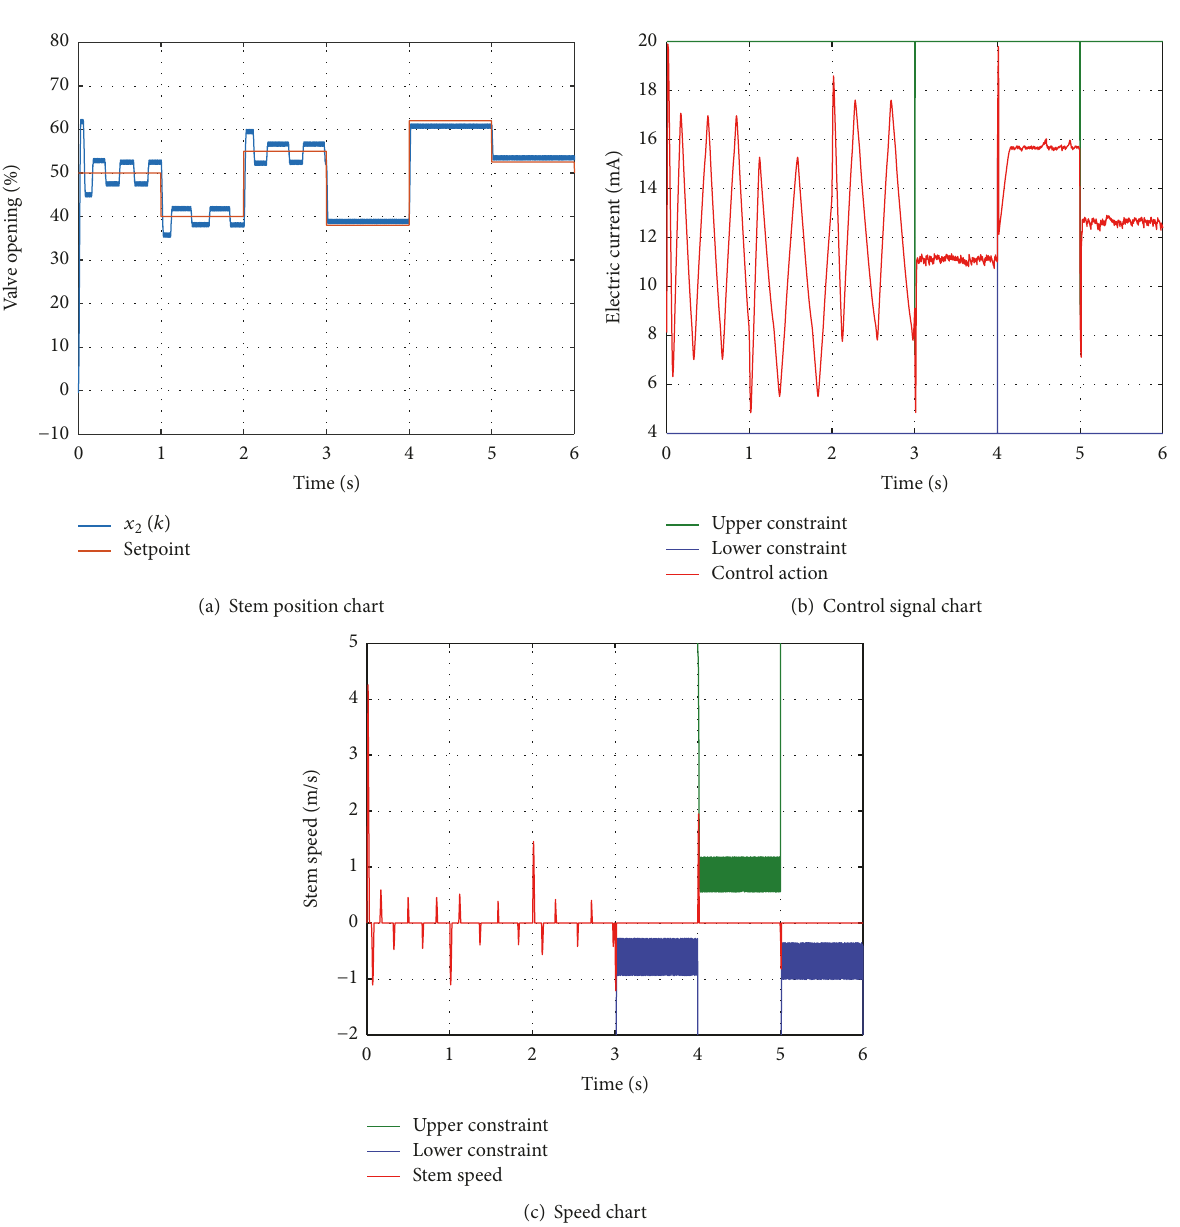
Figure 6: Simulation